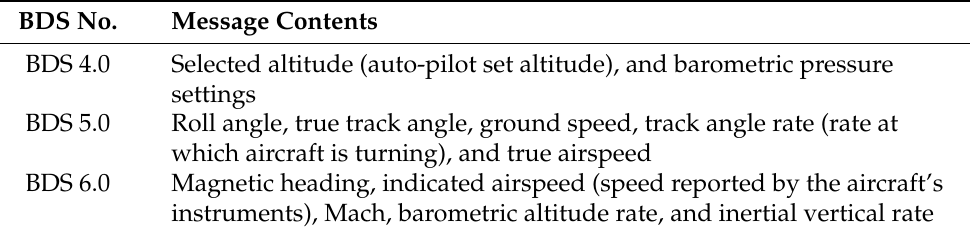
Table 1. Three most used BDS messages with their respective parameters